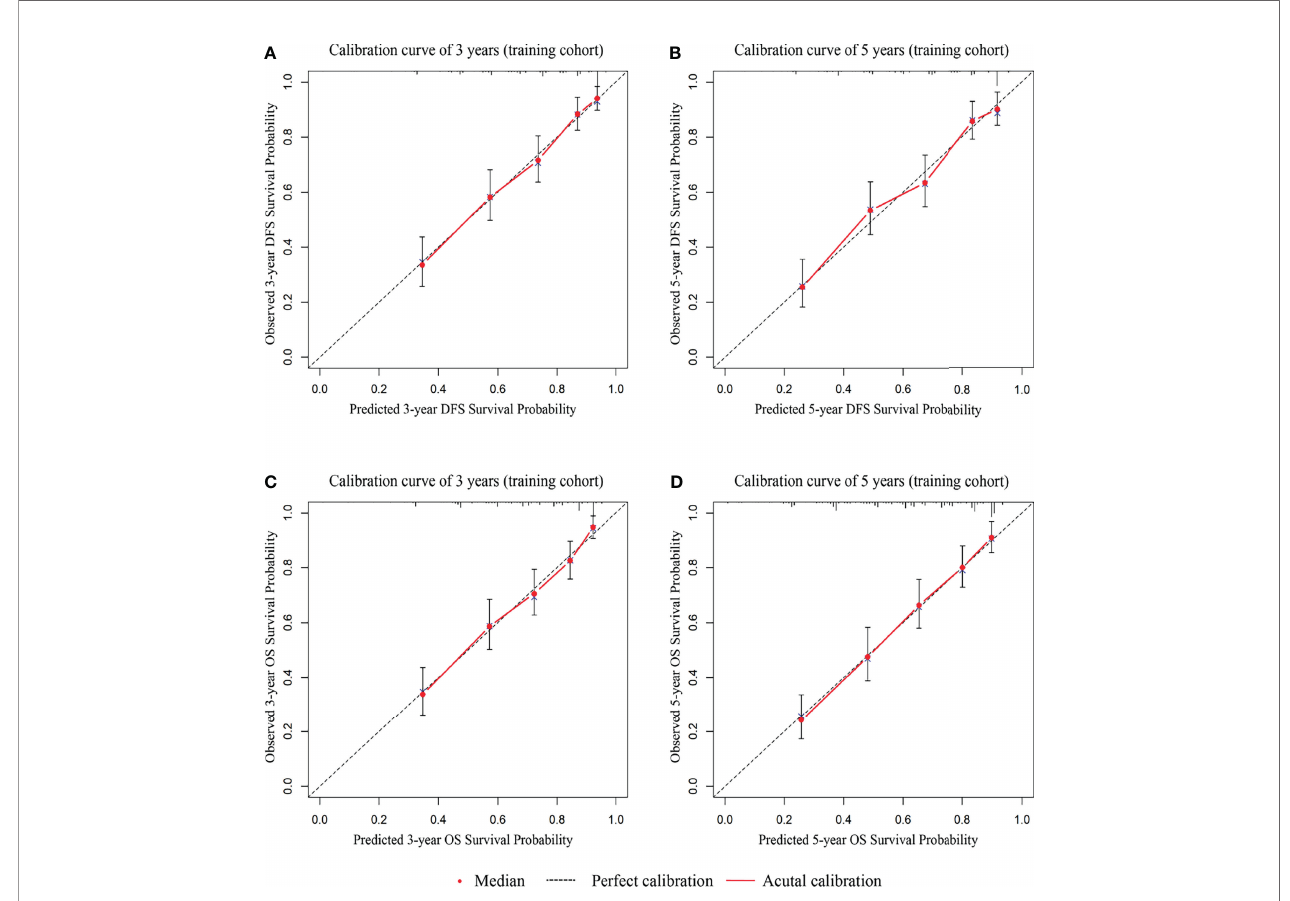
FIGURE 5 | The 3-year and 5-year calibration curves are based on the internal cohort nomograms between predicted and observed DFS and OS outcomes. (A) The 3-year calibration curve for DFS. (B) The 5-year calibration curve for DFS. (C) The 3-year calibration curve for OS. (D) The 5-year calibration curve for OS.